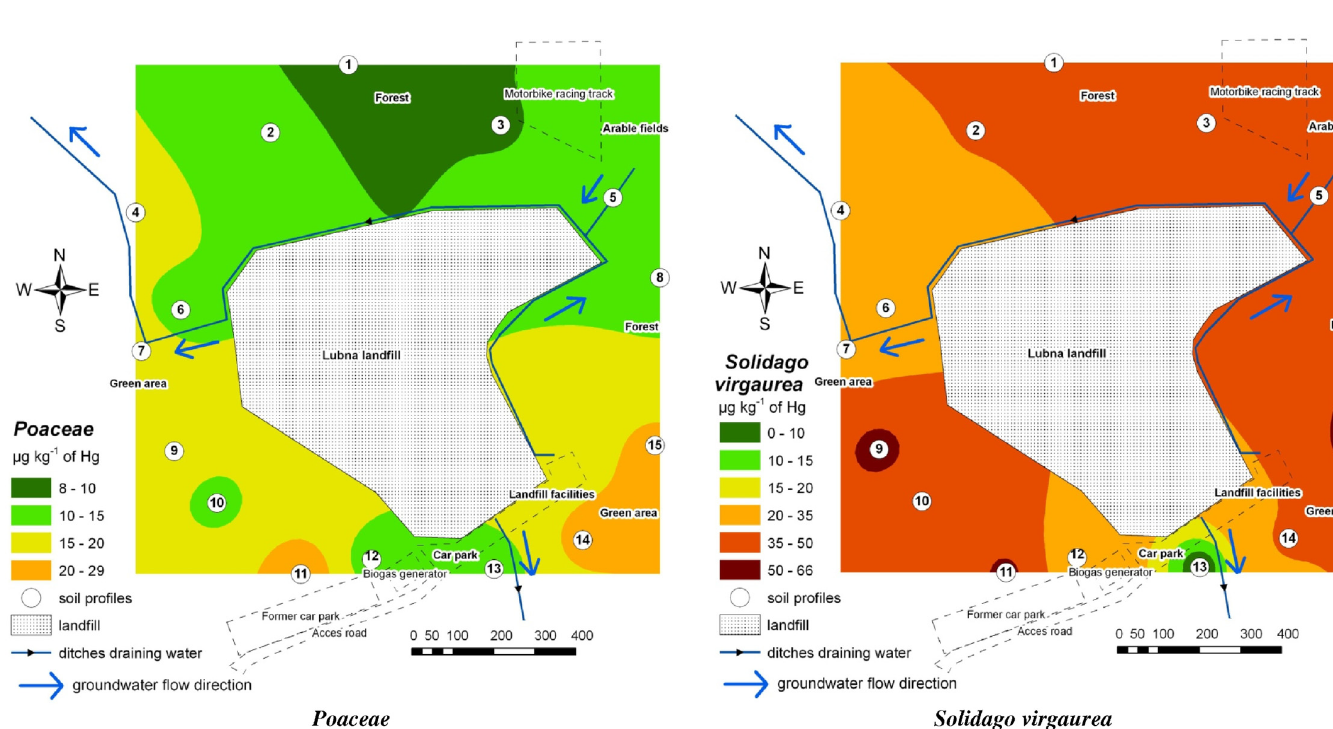
Fig 2. Contamination of the environment with THg based on the accumulated concentration of this element in plants ( Poaceae sp. and Solidago virgaurea ).